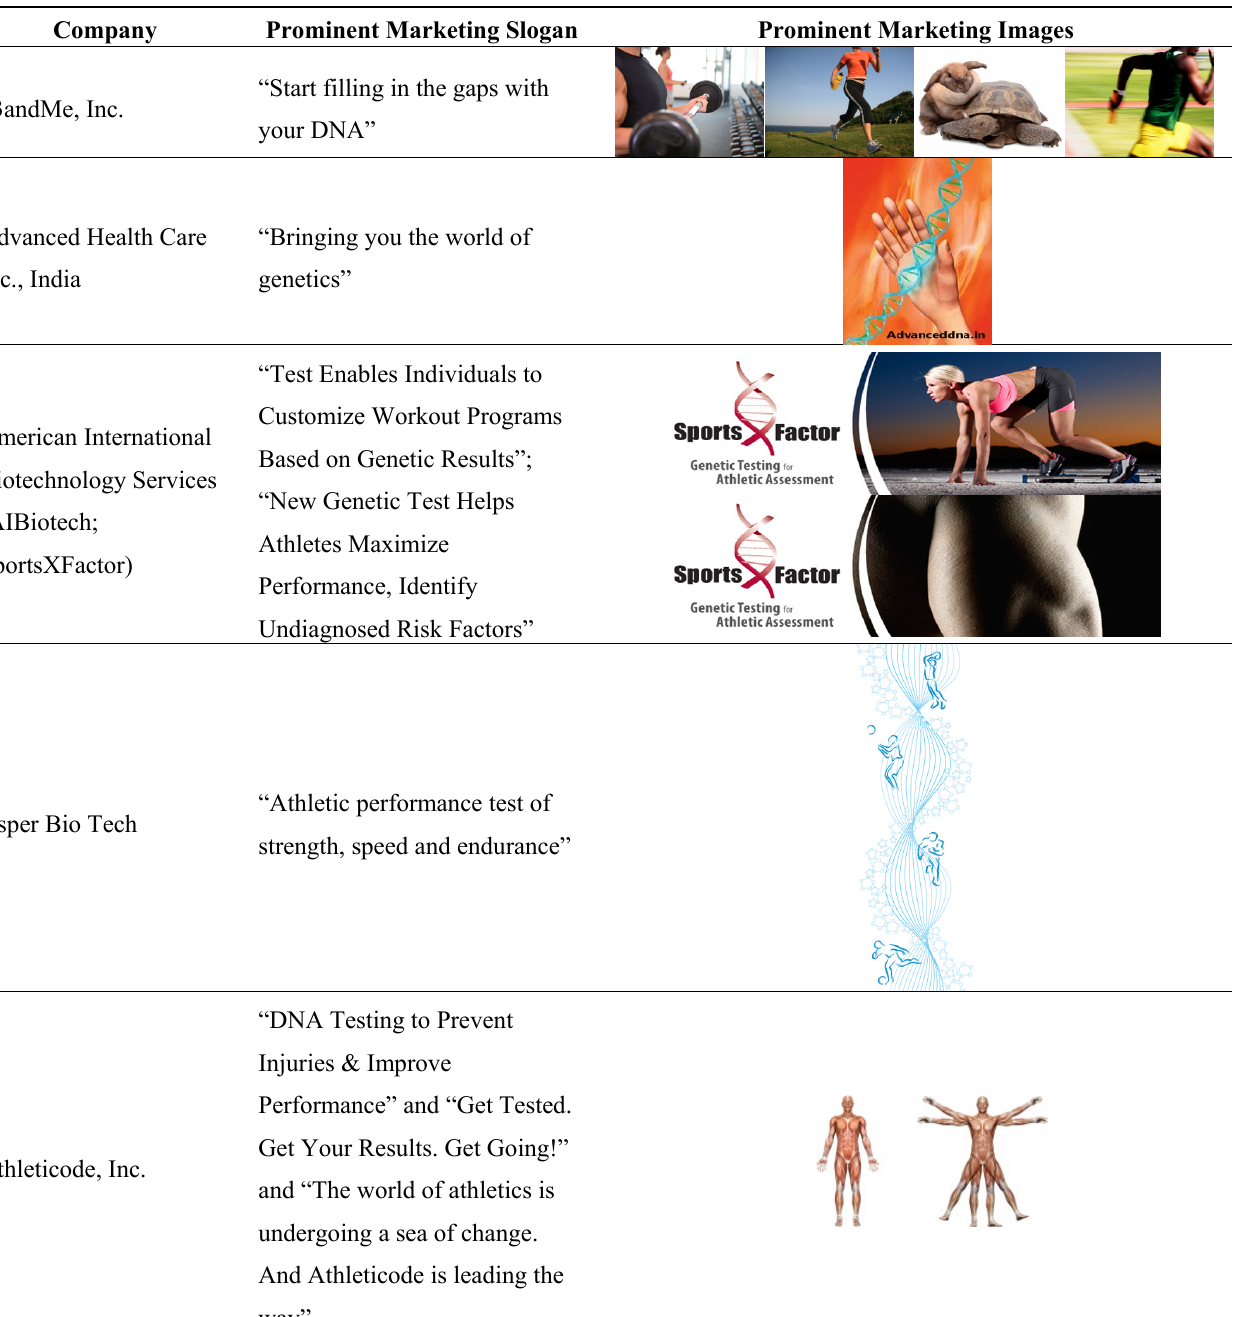
Table 3. Marketing of sports-related DNA